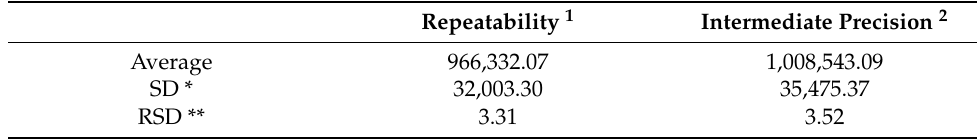
Table 3. Precision study on anthocyanins UAE from Erica australis